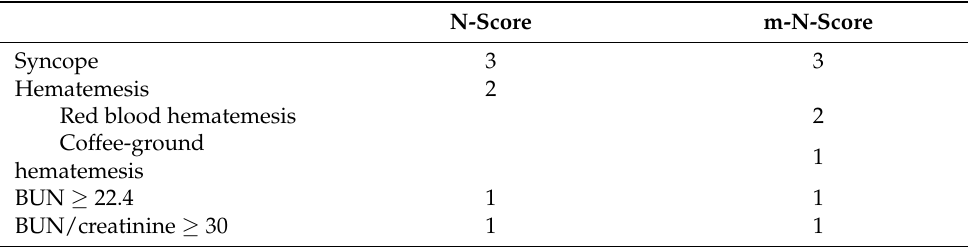
Table 6. N-score and proposed m-N-score [8].